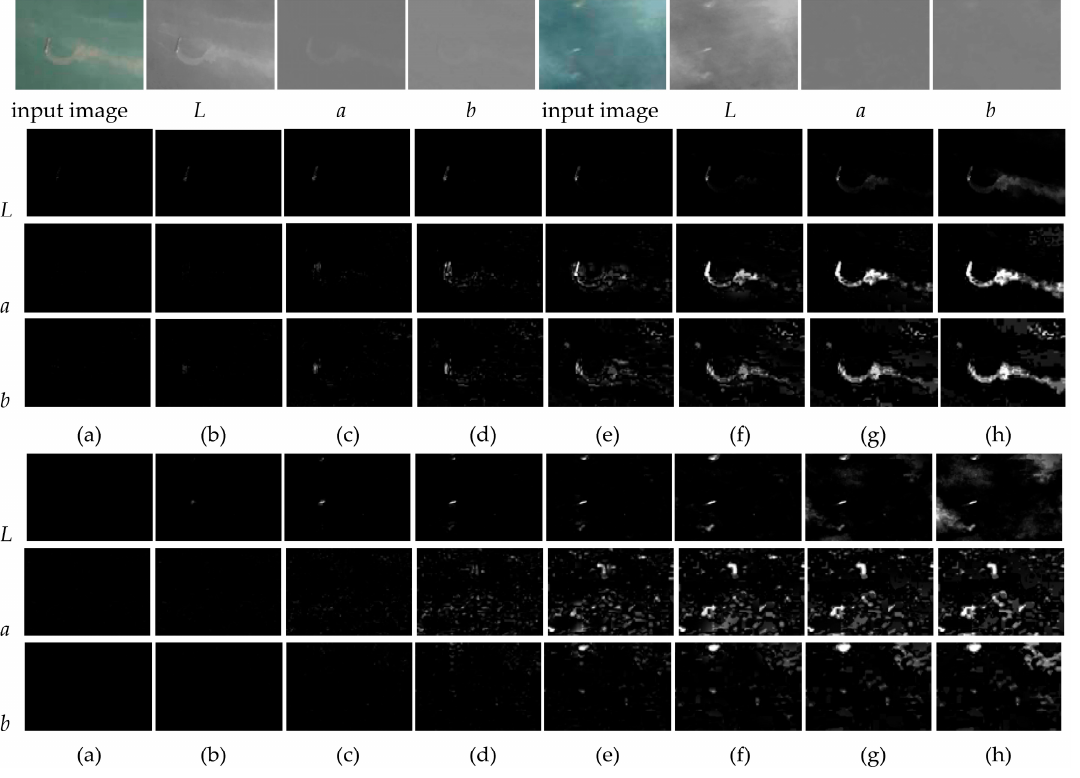
Figure 3. The feature maps from the Lab color space: ( a ) j = 1; ( b ) j = 2; ( c ) j = 3; ( d ) j = 4; ( e ) j = 5; ( f ) j = 6; ( g ) j = 7; and ( h ) j = 8.